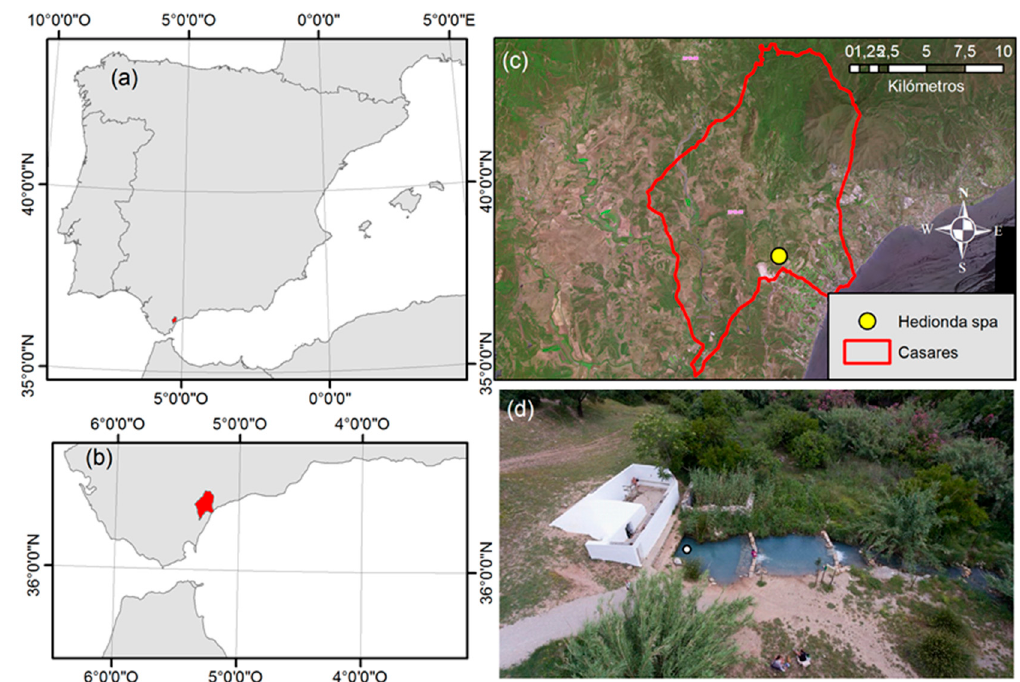
Figure 1. ( a ) Iberian Peninsula, ( b ) Municipality of Casares, ( c ) Location of Casares and La Hedionda spa, ( d ) La Hedionda spa with a roofed part on the left and the outflow in the open air on the right with the sampling point (white dot).